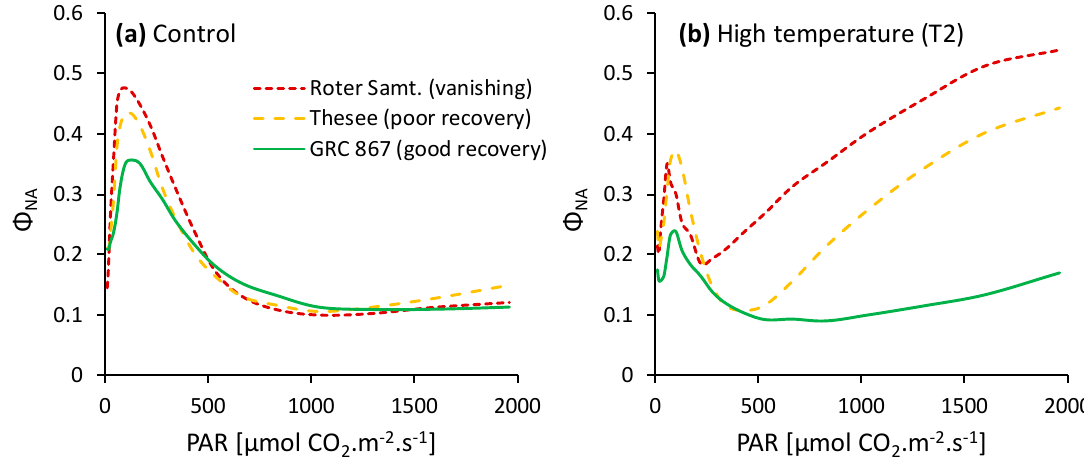
Figure 5. Examples of the light response curves of the PSI acceptor side limitation parameter ( Φ NA ) measured in control plants ( a ) and in plants exposed to the heat wave ( b ) of three genotypes differing in their capacity to recover after the withdrawal of heat stress.